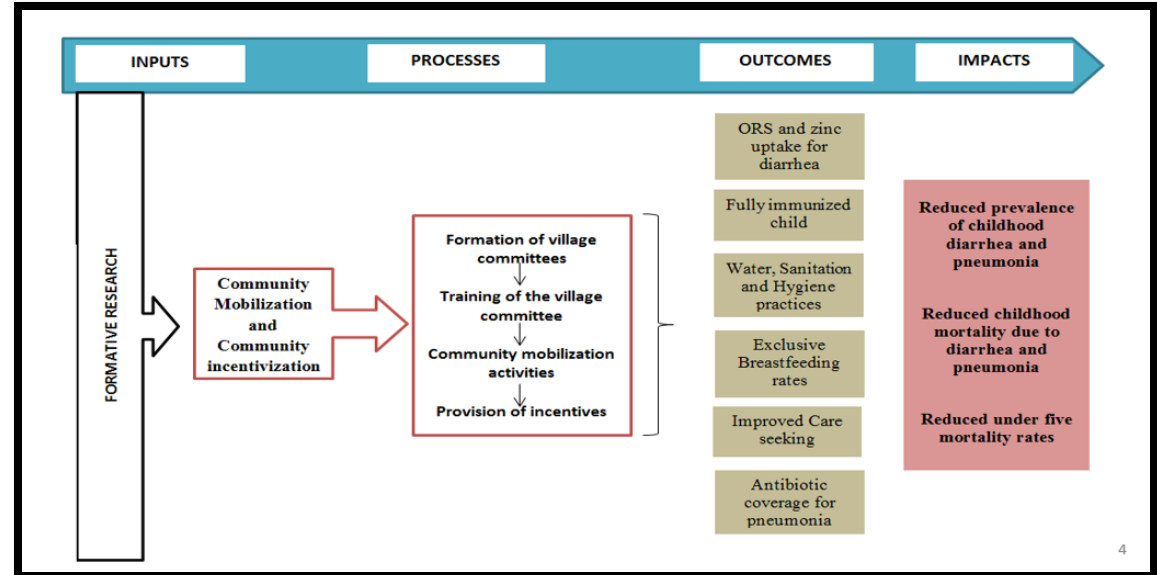
Figure 2. Design of the CoMIC trial.